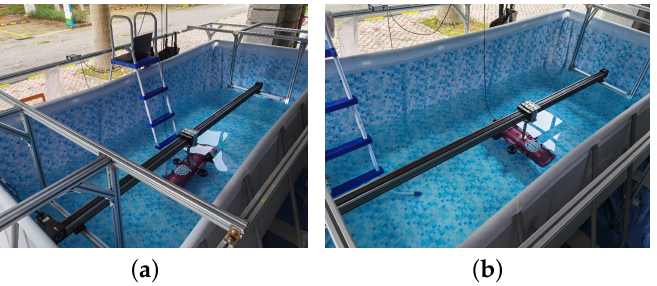
Figure 21. Straight-line motion test of the underwater vehicle on the physical experiment platform. ( a ) Straight-line motion along x -direction; and ( b ) straight-line motion along y